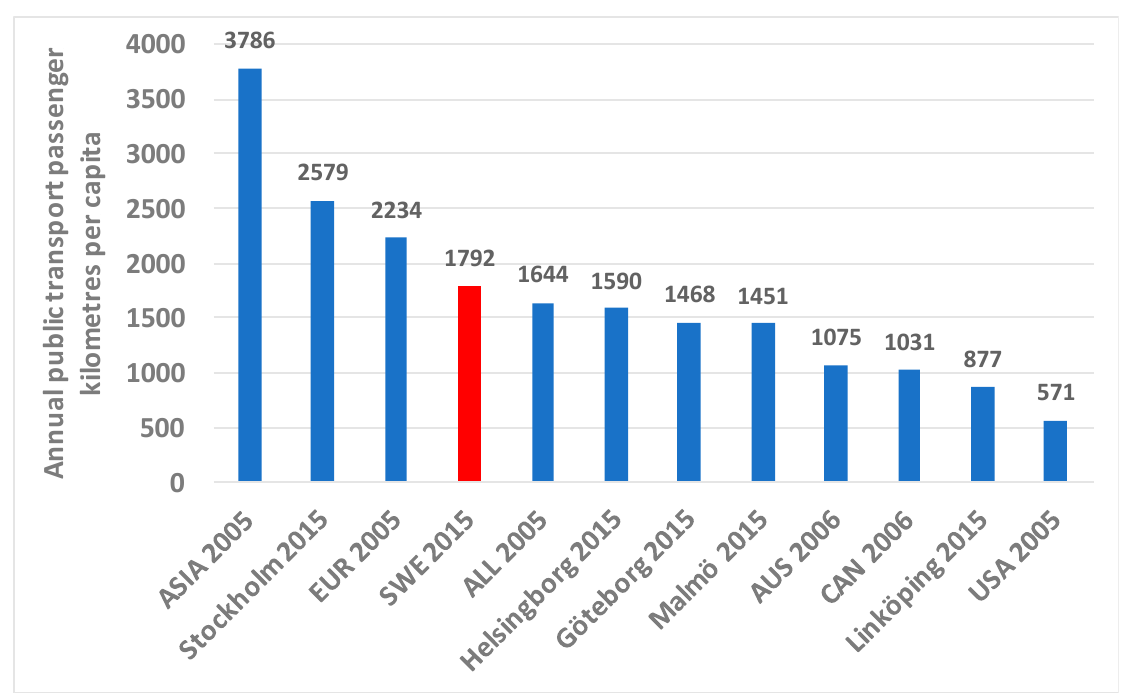
Figure 10. Annual public transport passenger kilometres per person in five Swedish cities (2015) compared to a sample of global cities (2005–2006).